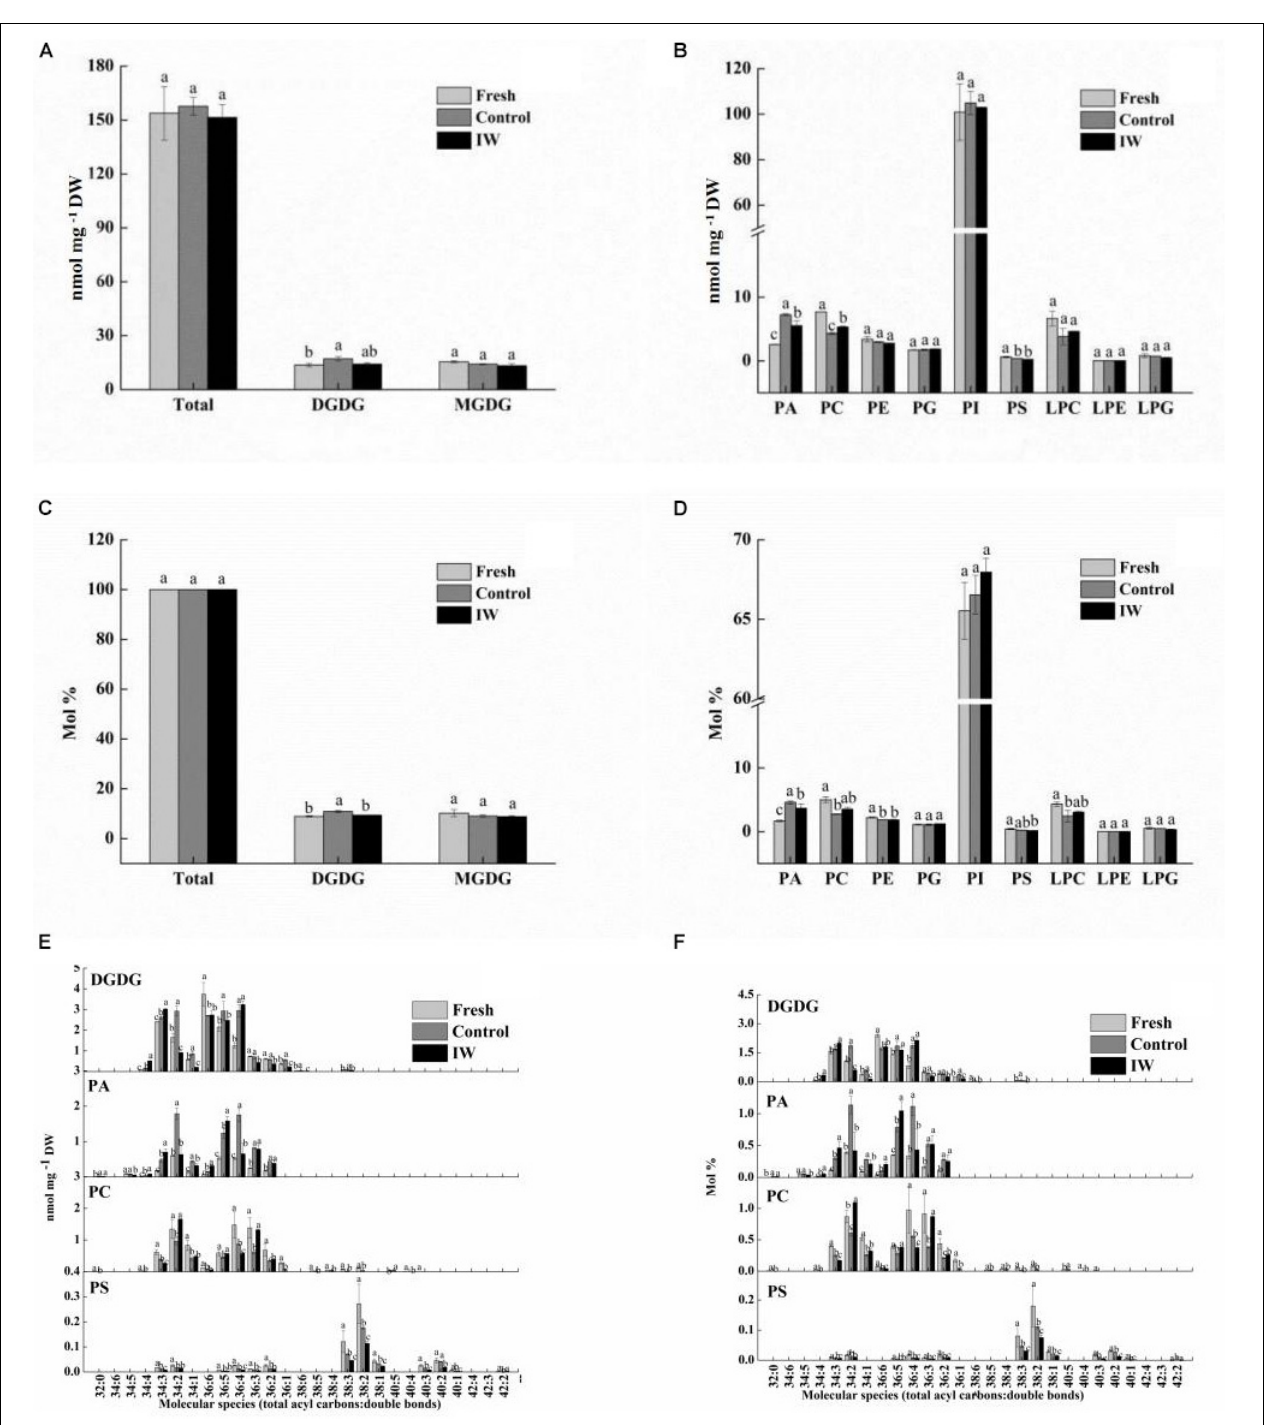
FIGURE 3 | Effect of intermittent warming on membrane lipid content of blueberry fruit at the day 4 during shelf life at room temperature after 30-day refrigeration. (A) Total lipid and glycolipid composition changes during shelf life, (B) phospholipid composition changes during shelf life, (C) total lipid and glycolipid proportion changes during shelf life, (D) phospholipid proportion changes during shelf life, (E) main glycolipid and phospholipid molecular species composition changes during shelf life, and (F) main glycolipid and phospholipid molecular species proportion changes during shelf life. Mean ± SE of three replicate experiments are shown. The letters a, b, and c show significant differences according to the independent samples t -test ( p < 0.05) at each time point.